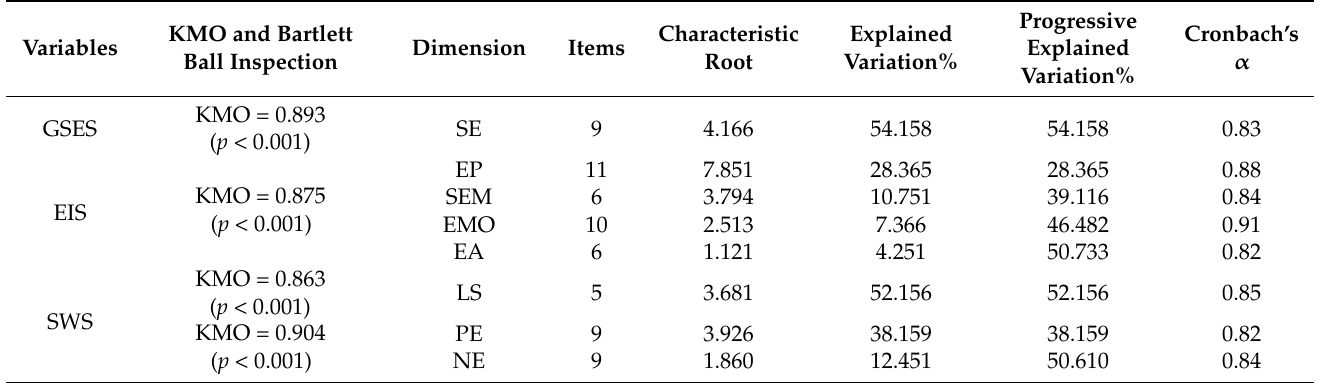
Table 1. Factor extraction and reliability analysis of three measurement